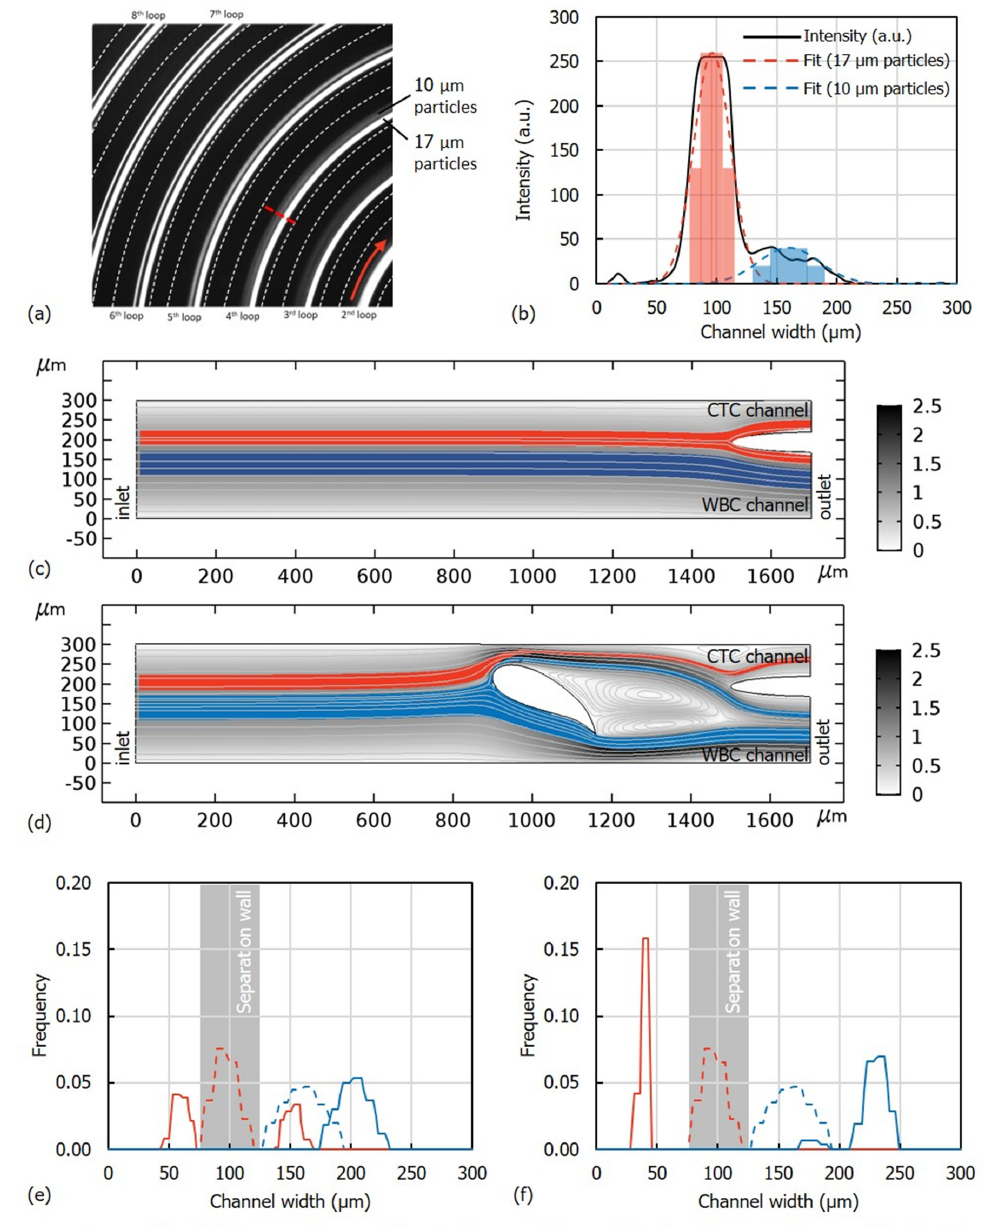
Figure 2. ( a ) Focusing of 10 µm and 17 µm fluorescent beads in a spiral channel with 8 loops. ( b ) Grayscale intensity profile of the beads across the channel at the 4th loop. Solid line denotes the measured intensity. Dash lines denote the Gaussian curves fitted to the intensity profile, to represent the individual distributions of the beads. Pale red and pale blue shaded regions denote the discretized distribution of the particles, as the input to the simulation model. Velocity field and the trajectories of the particles in the channel at the downstream of the spiral (Figure 1) ( c ) in the absence of the hydrofoil and ( d ) in the presence of the hydrofoil. Red and blue streams represent 17 µm and 10 µm particles, respectively. The scale bar indicates the flow velocity in m/s. Distribution of 10 µm and 17 µm particles at the inlet and the outlet ( e ) in the absence of the hydrofoil and ( f ) in the presence of the hydrofoil. The resolution at the upstream R u = 2.24 was increased to the resolution at the downstream R d = 30.46, which shows the effect of using hydrofoil to enhance separation.